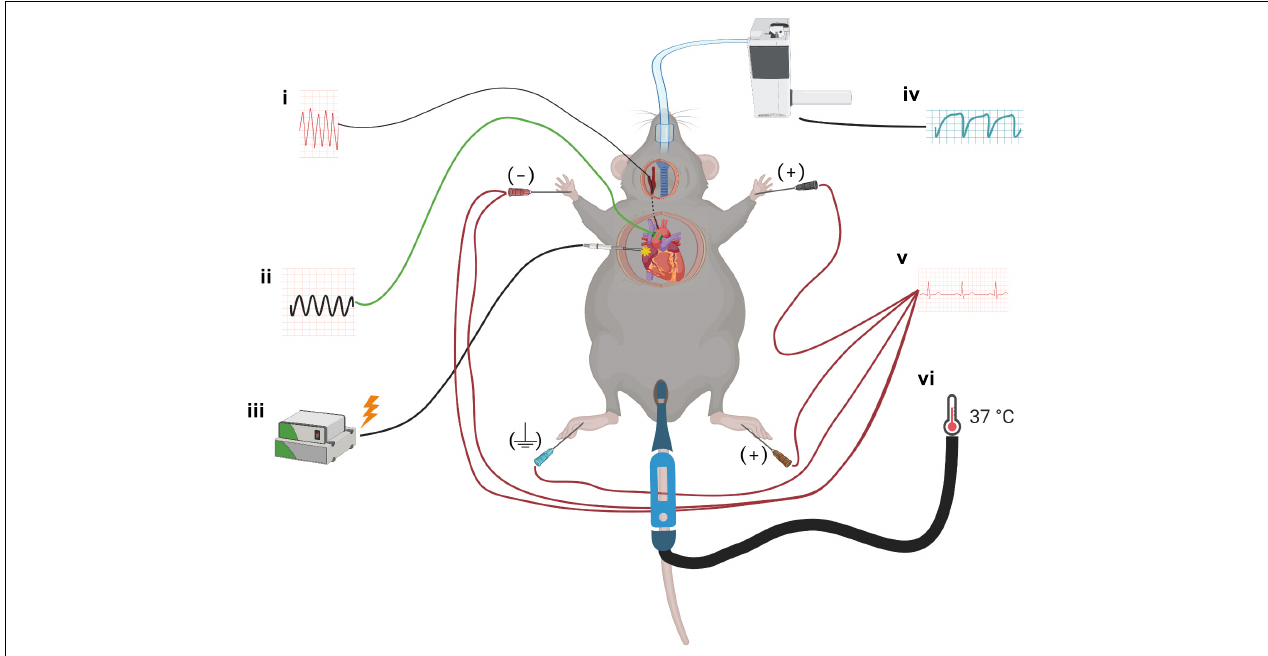
FIGURE 1 | A schematic for the experimental setup. Mice were anesthetized with isoflurane, and probes to monitor the cardiovascular parameters were implanted: (i) solid-state pressure catheter was inserted through the common carotid artery and placed in the arcus aorta, (ii) transit-time flow probe was mounted on the ascending aorta to measure cardiac output, (iii) bipolar electrodes were placed at the right atrium for cardiac pacing, (iv) mice were intubated endotracheally for mechanical ventilation, (v) ECG needle electrodes were placed on all four limbs to monitor heart rate and ECG parameters, and (vi) throughout the surgery and protocol, mice were placed on a homeothermic blanket system with a rectal probe to maintain core temperature.